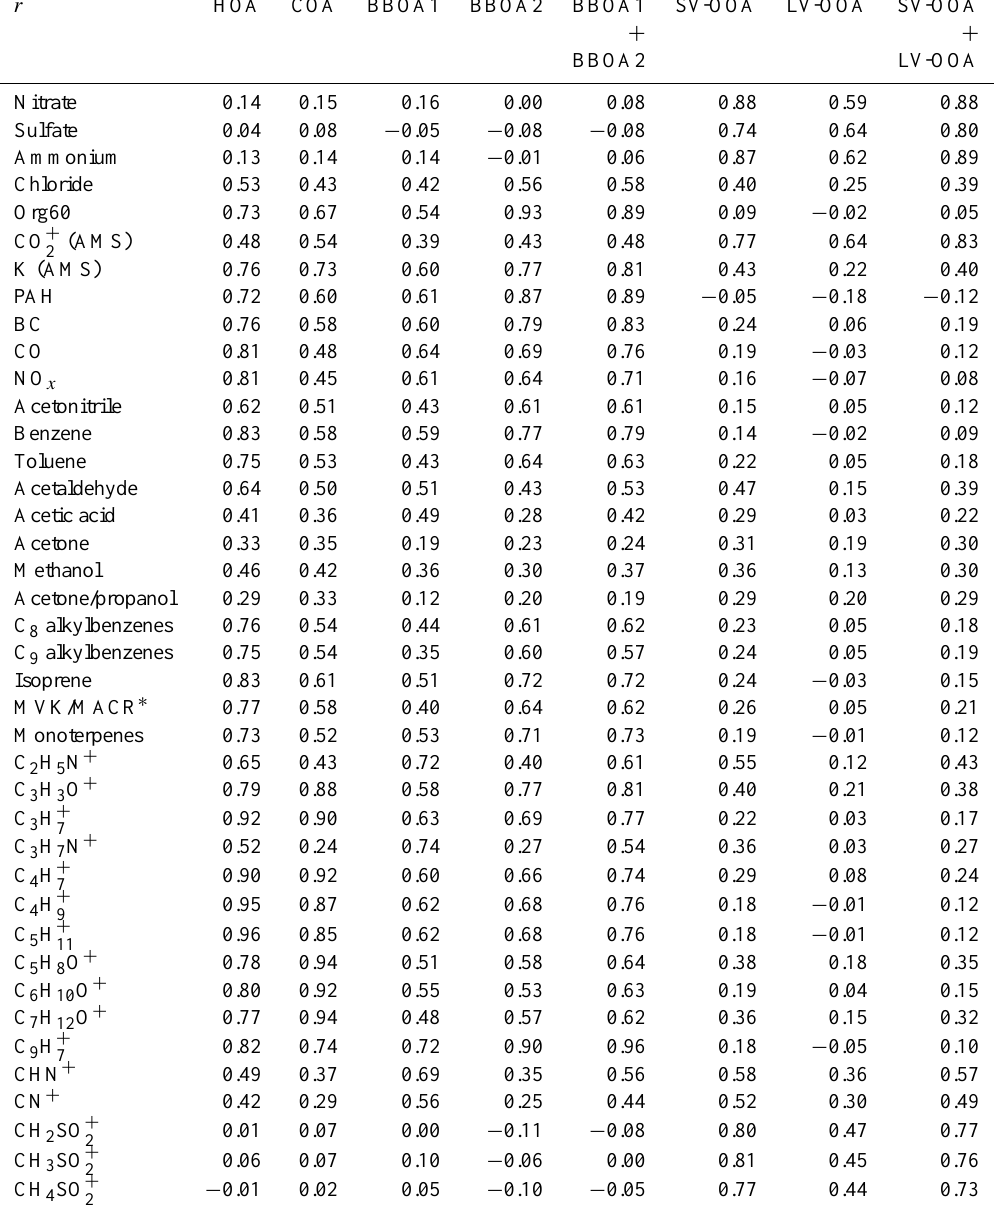
Table 2. Correlation coefficient (Pearson’s r ) for linear regressions between OA factors (including the sum of both BBOA factors as well as the sum of the OOA factors) and various particle- and gas-phase species and